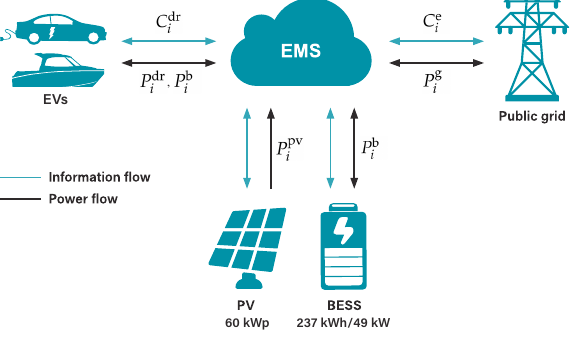
Figure 1. Marina’s energy management system